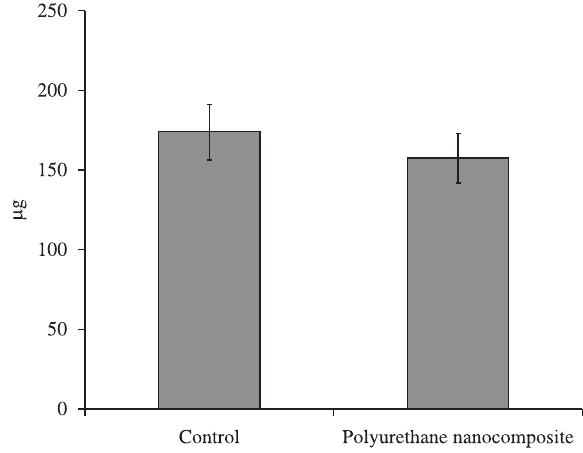
Figure 8. Collagen type I expression: no statistical difference between the expression of collagen by cells cultured in contact with the nanocomposite and on TCPS (control) was noticed.